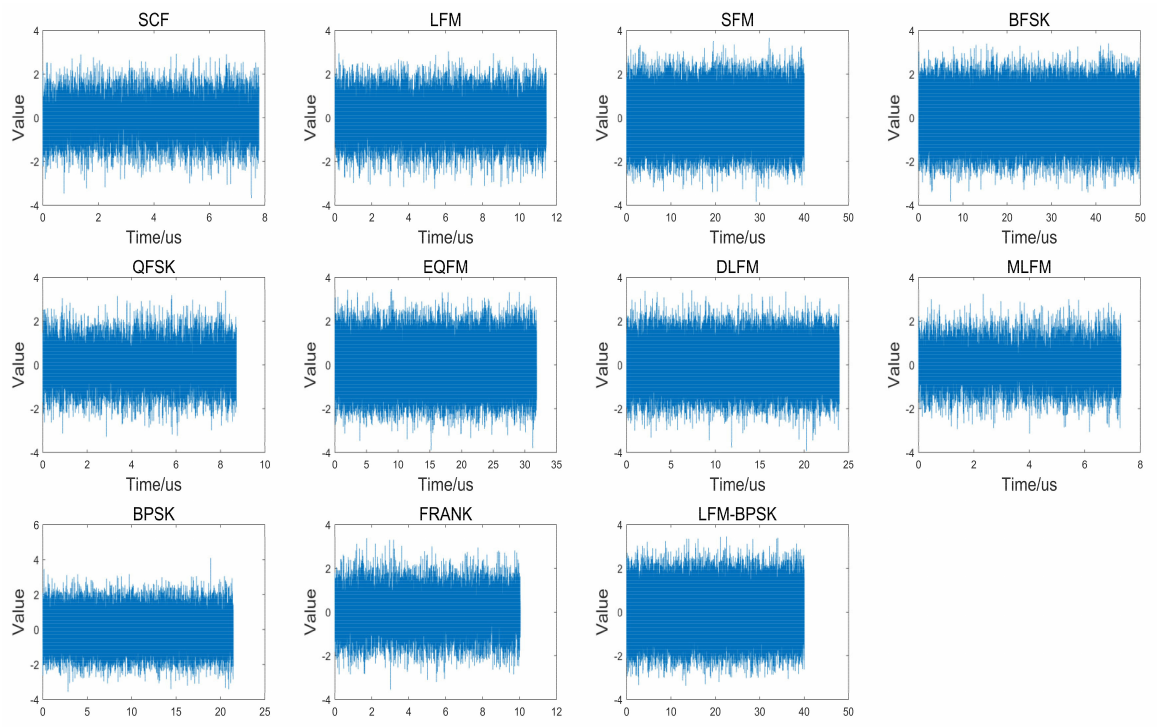
Figure 3. The original waveforms of eleven intra-pulse modulations radar emitter signal samples in time domain when the SNR is 0